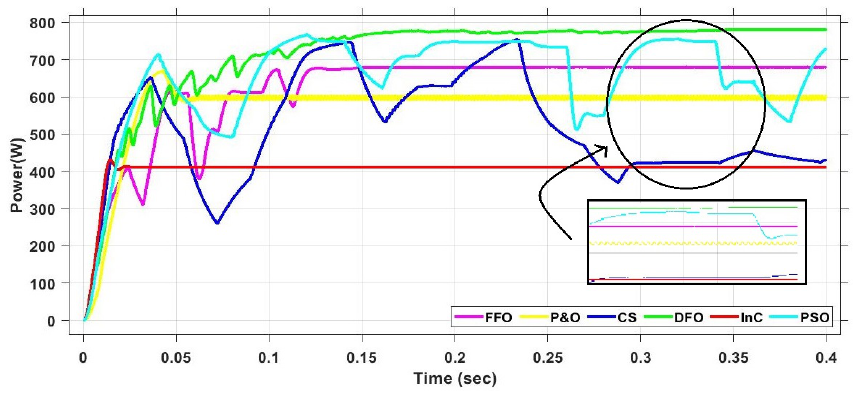
Figure 19. PS3 power comparison between all algorithms for centralized PV